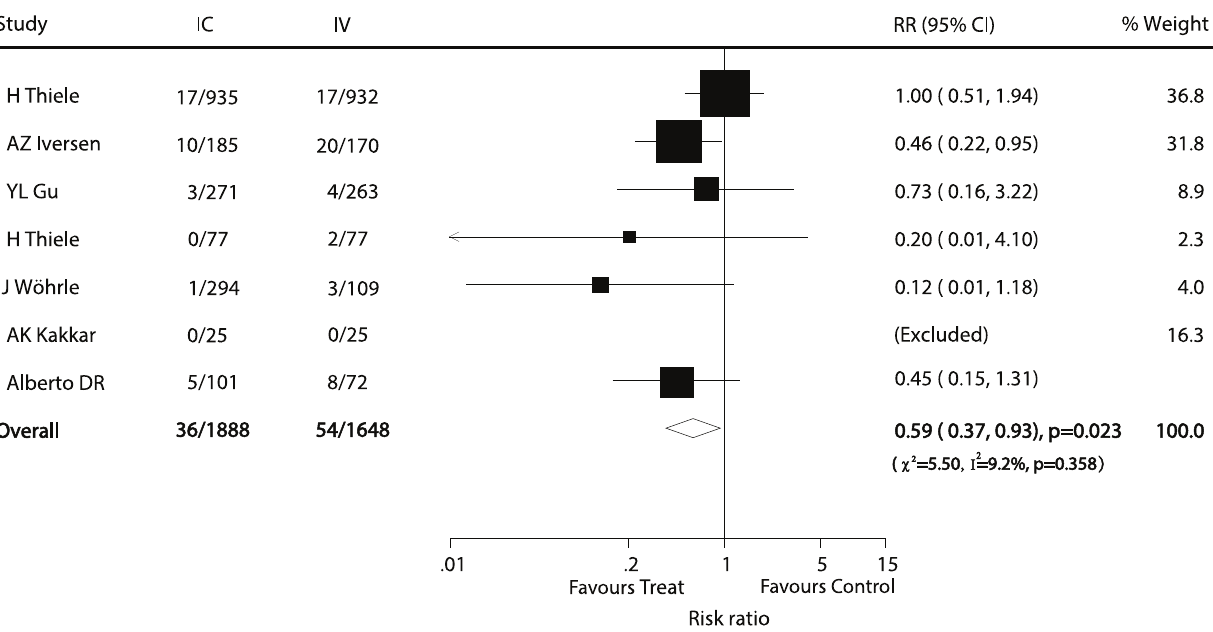
Figure 4. Effects of IC administration of abciximab on risk of reinfarction as compared to IV therapy in patients with ACS.